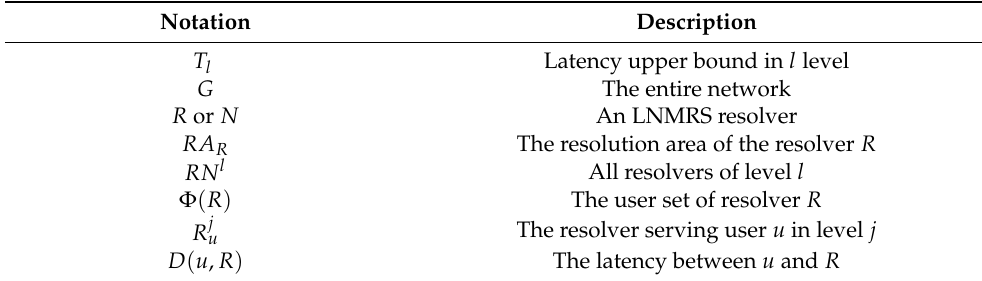
Table 2. Summary of